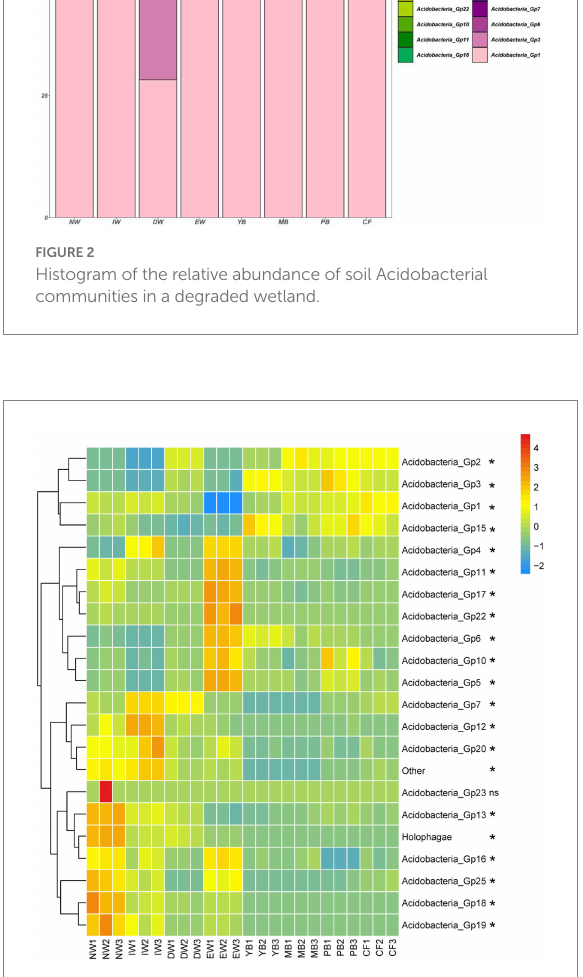
FIGURE 3 Heatmaps of Acidobacterial composition differences in different vegetation types in Sanjiang plain. *means one-way ANOVA significant at p < 0.05. The color gradient (red, yellow, blue) represents the relative abundance of the soil Acidobacteria from high to low in the different vegetation